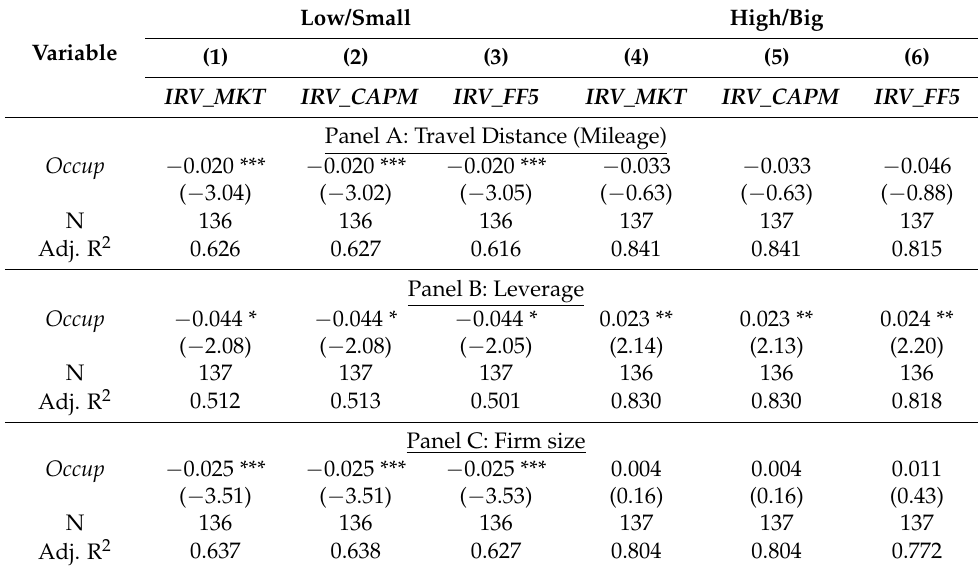
Table 3. Subsample